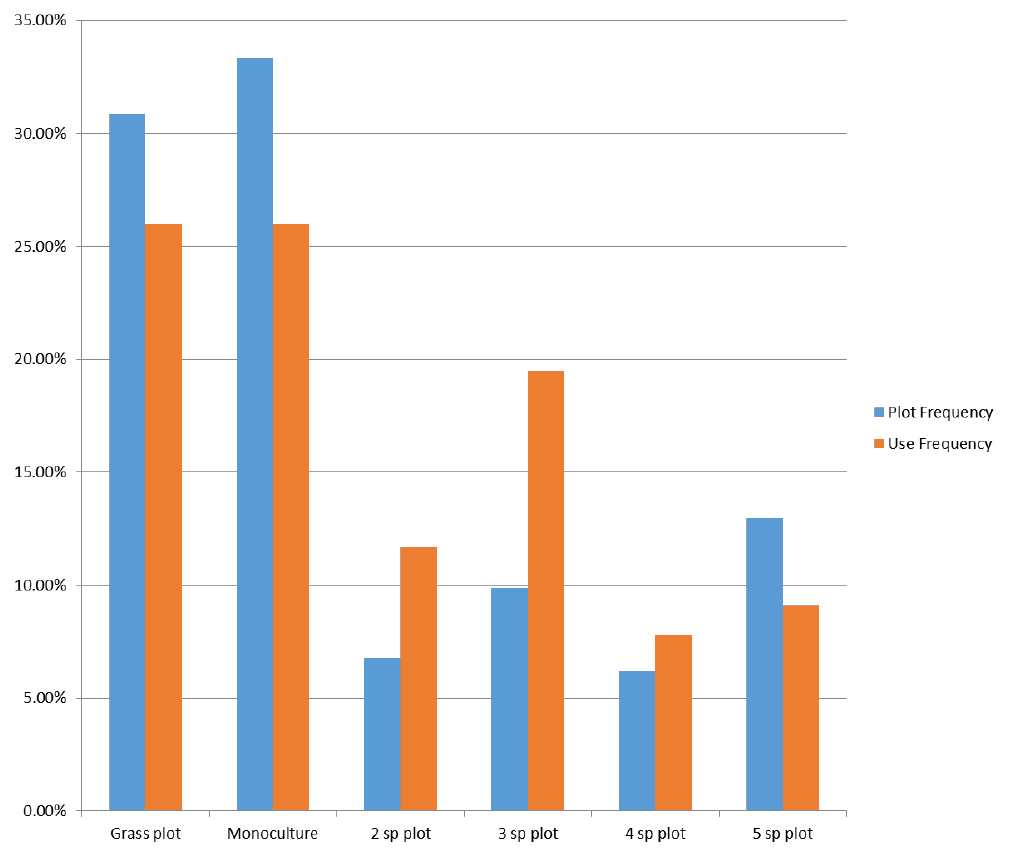
Figure 13. Honey bee use of plots of varying plant diversity as mapped by use of bee-mapping